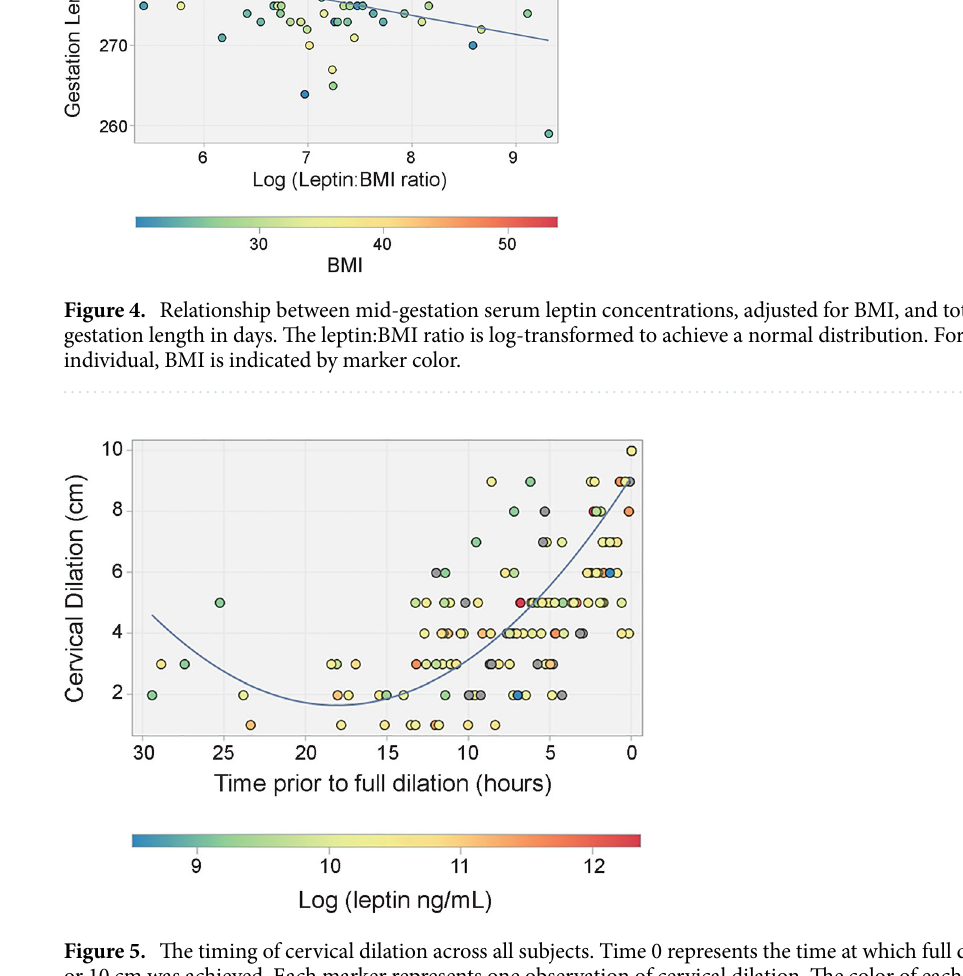
Figure 5. The timing of cervical dilation across all subjects. Time 0 represents the time at which full dilation or 10 cm was achieved. Each marker represents one observation of cervical dilation. The color of each marker indicates log (leptin). Leptin was not a significant factor in timing of cervical dilation (β = −0.06, p = 0.7) when controlling for confounding